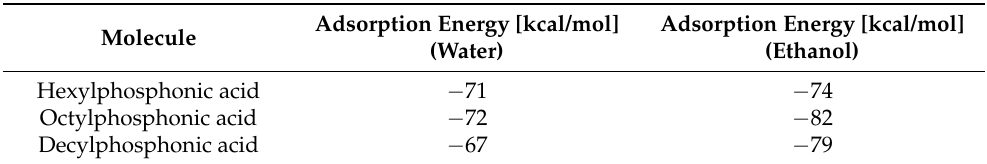
Table 2. The adsorption energy of hexyl-, octyl-and decylphosphonic acids on the Cu (111) surface in aqueous medium and ethanol.